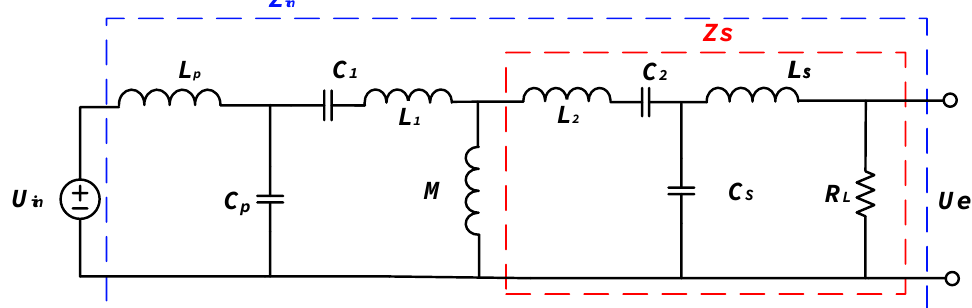
Figure 2. Equivalent schematic of double-sided LCC resonant compensation network.